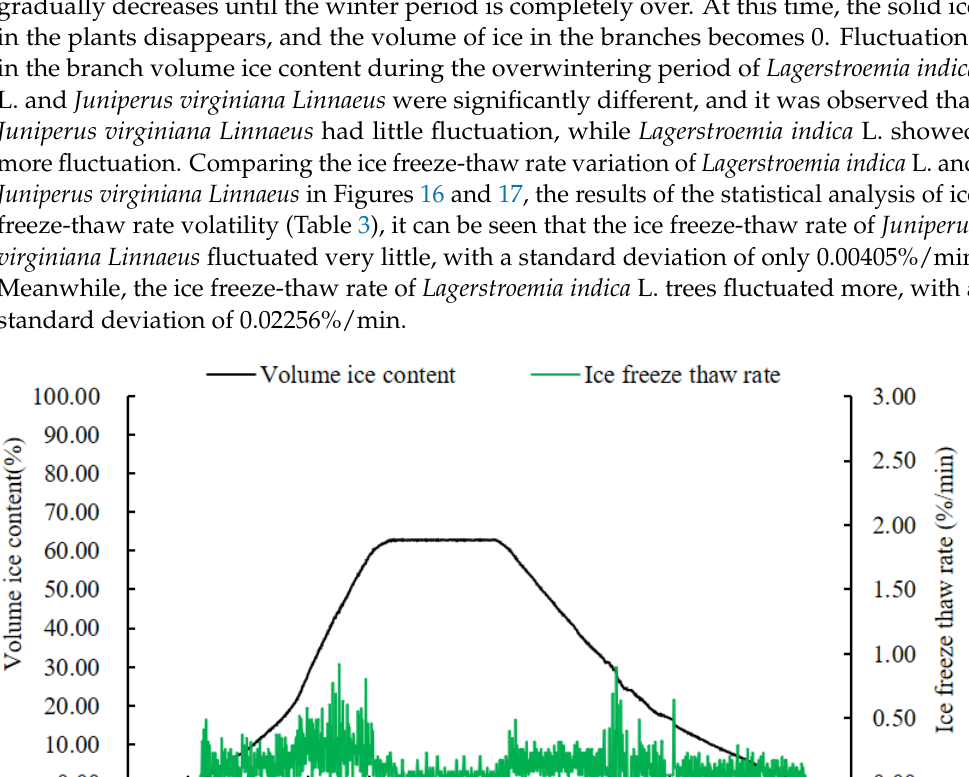
Table 2. Fitting equations for the values of the volumetric moisture content of the branches and the output voltage values of the measurement circuit.